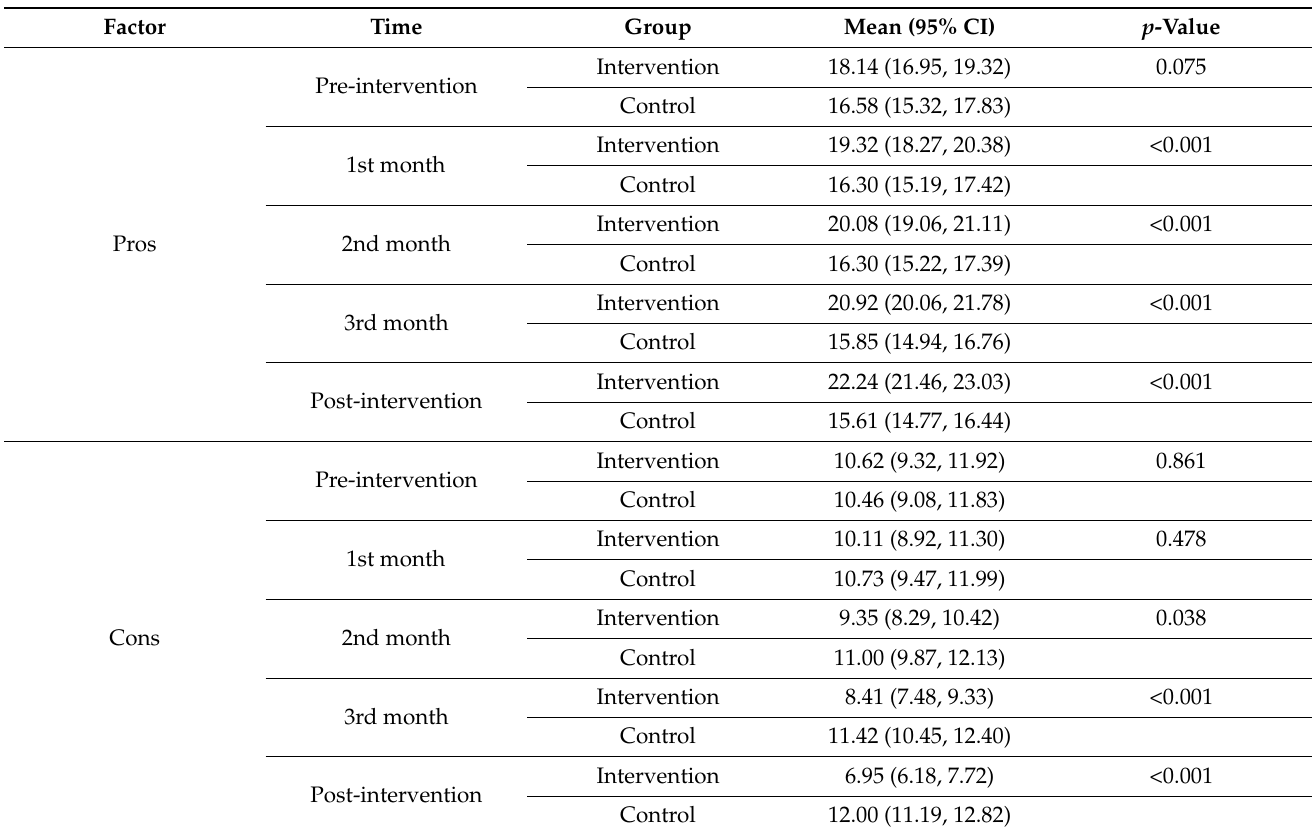
Table 4. Comparison of the mean score for Pros and Cons from the DB-M scale among two groups based on time (Time ∗ Group